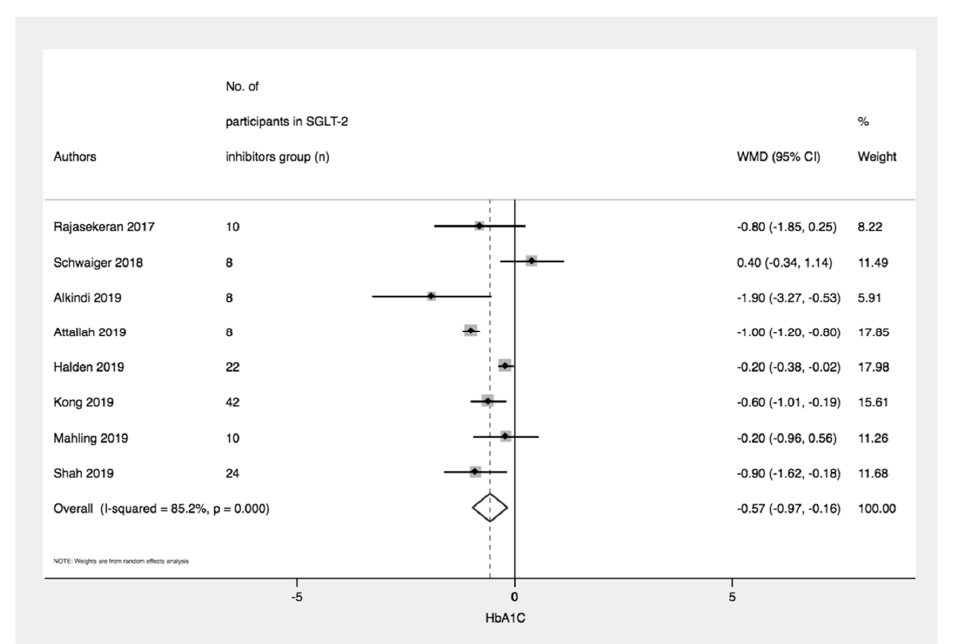
Figure 3. Forest plot displaying the pooled weighted mean difference of glycated hemoglobin (HbA1C), comparing levels at baseline and end of study.